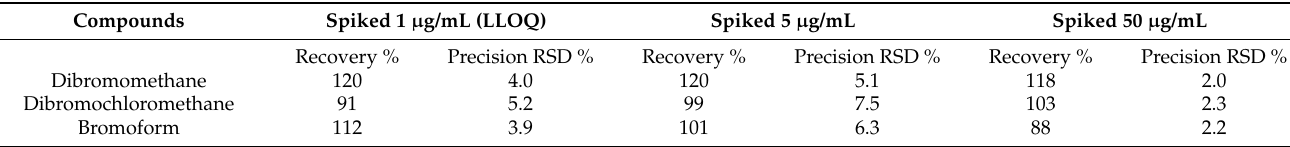
Table 4. Recovery % and precision (RSD) of the